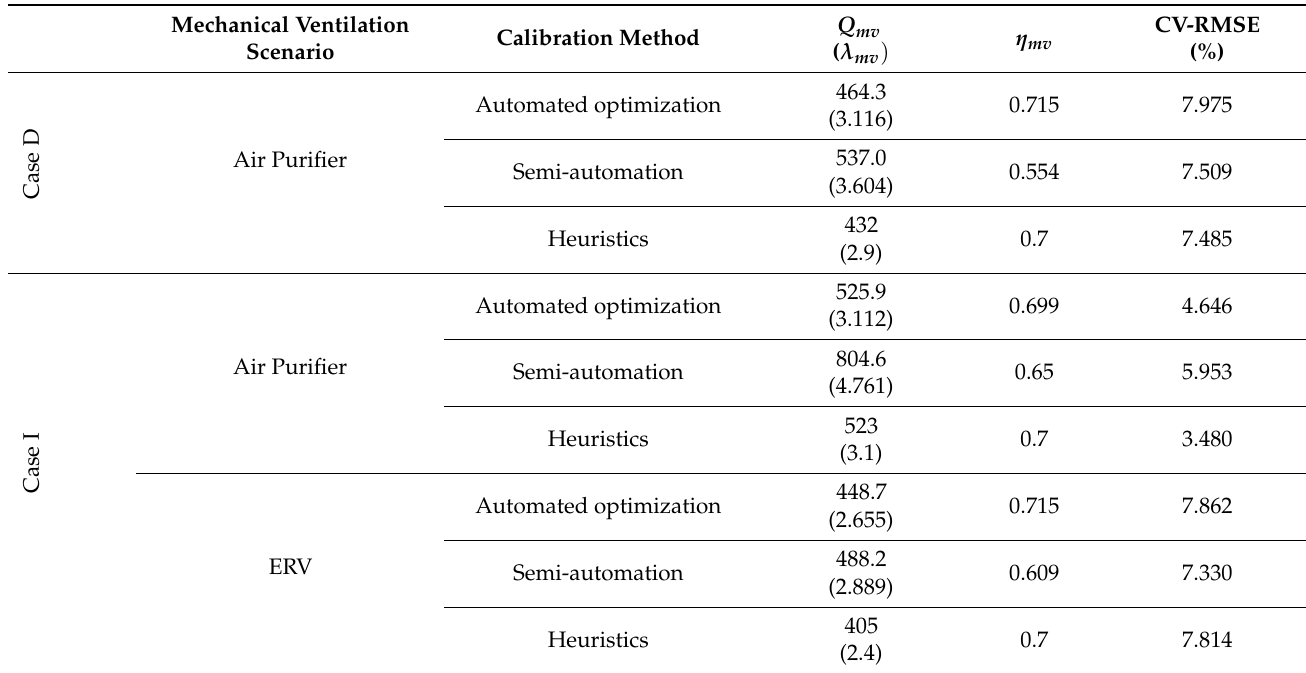
Table 5. Estimated values of the control variables for the mechanical ventilation